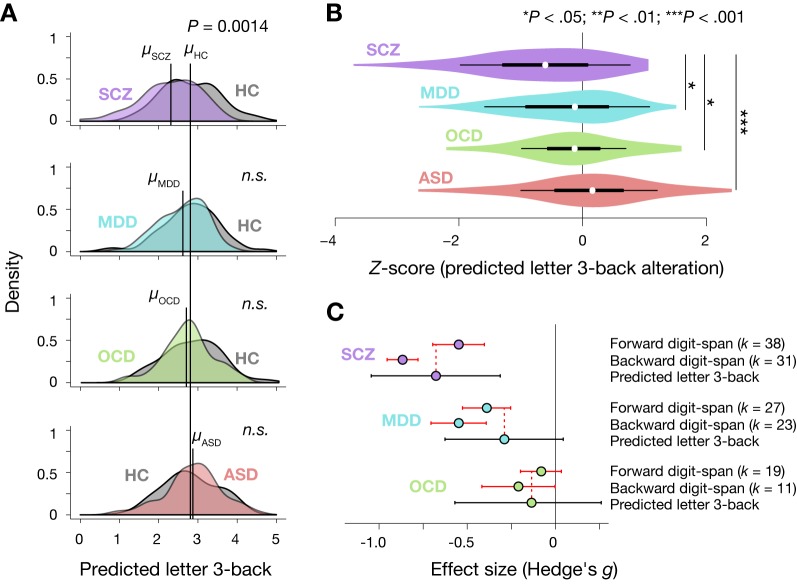
Prediction of diagnosis-specific alterations of working memory ability.(A) Predicted letter 3-back working memory ability for patients (N = 58, 77, 45, and 69 for SCZ, MDD, OCD, and ASD, respectively) and their age- and gender-matched healthy/typically developed controls (HC, N = 60, 62, 47, and 71) shown as kernel density. For illustration purposes, distribution of each control group was standardized to that of the ATR dataset, and the same linear transformation was applied to patients’ distributions. μ indicates mean value for each group. (B) Violin plots of Z-scores for predicted working memory ability alterations. White circles indicate medians. Box limits indicate 25th and 75th percentiles. Whiskers extend 1.5 times interquartile range from 25th and 75th percentiles. (C) Comparison of estimated effect sizes for working memory deficits. k indicates number of studies included in the meta-analyses (Forbes et al., 2009; Snyder, 2014; Snyder et al., 2015). Error bars indicate 95% confidence intervals.